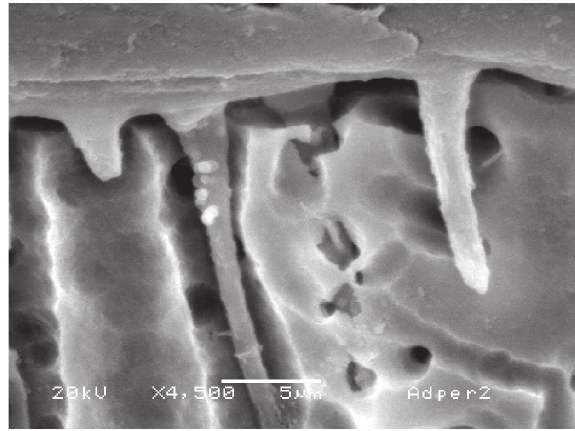
Figure 10- The strong self-etching systems may result in long and funnel-shaped resin tags due to their aggressiveness. This image was obtained using Adper Prompt L-Pop, which has a pH of 0.8